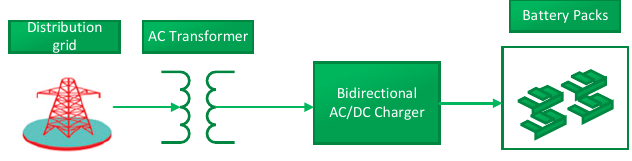
Figure 7. Block diagram of BSS electrical design.